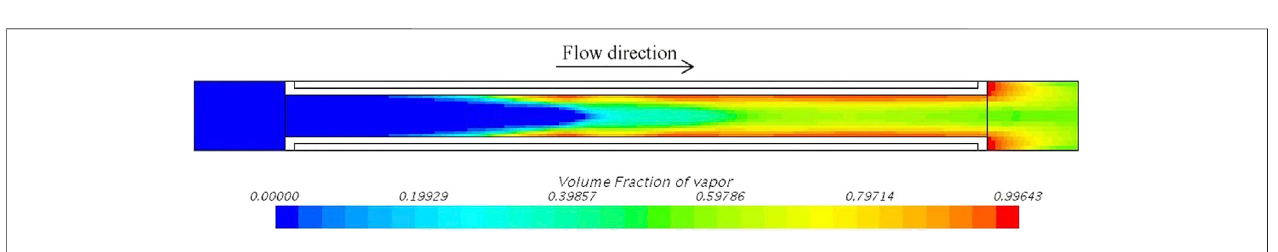
FIGURE 8 | Void fraction distribution with 0.5 m/s inlet velocity (scale: x : z (cid:1) 1:20).